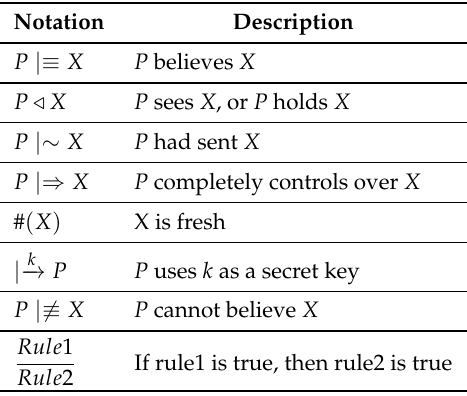
Table 2. Notation and descriptions for Burrows, Abadi, and Needham (BAN) logic.